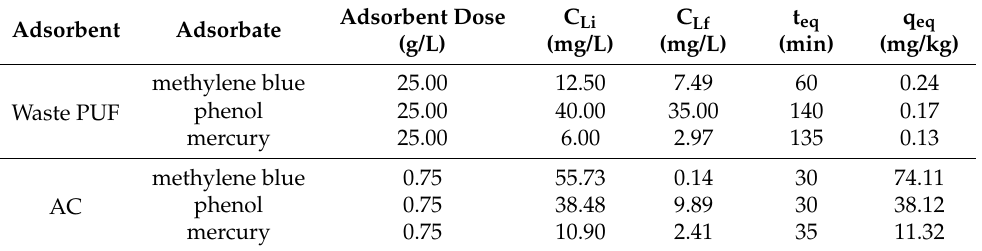
Table 3. Details and results of the adsorption equilibrium tests performed on PUF and AC (C Li : initial concentration in the liquid phase; C Lf : final concentration in the liquid phase; t eq : equilibrium time; q eq : amount of contaminant transferred on the